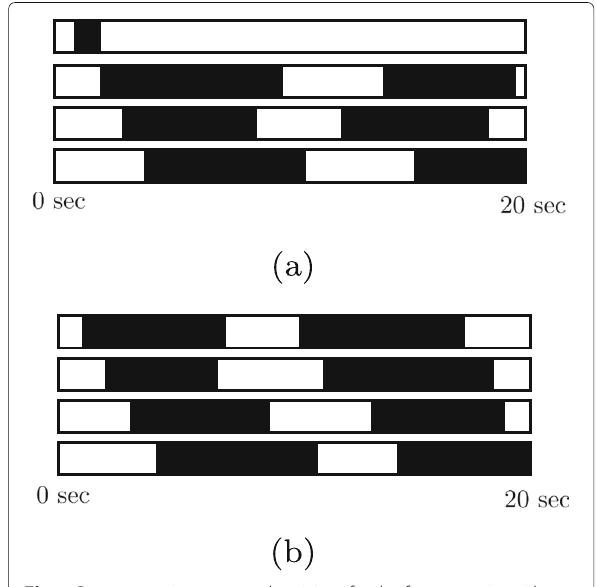
Fig. 4 Representative temporal activity of a the first scenario with a mixture of J = 4 participants, consisting of one speaker with low activity, and b the second scenario with a mixture of J = 4 participants with balanced activity